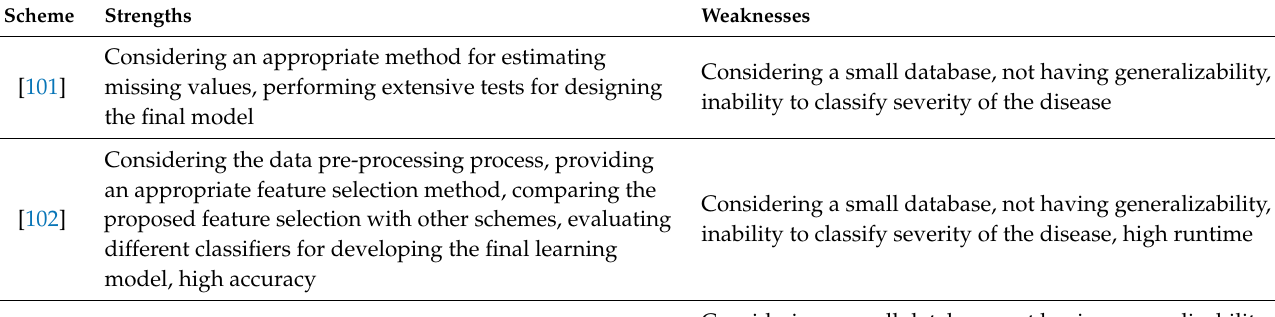
Table 9. The most important strengths and weaknesses of supervised learning-based